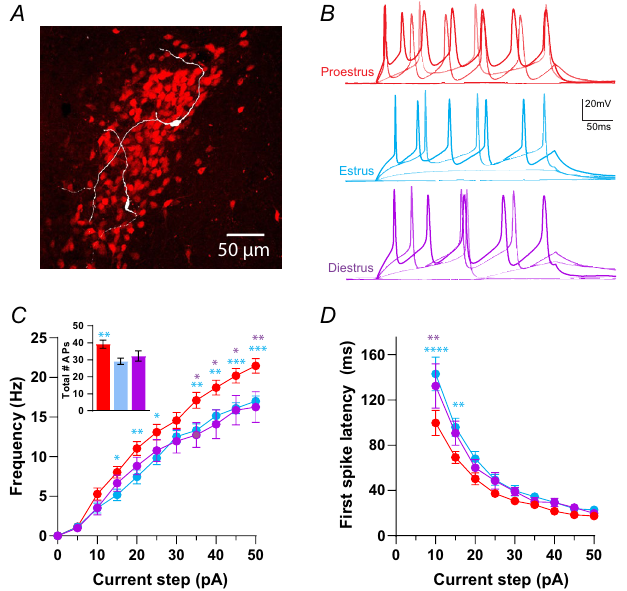
Figure 1. CRH neuron intrinsic excitability varies across the female estrous cycle. ( A ) Image of left hemisphere PVN showing expression of tdTomato (red) in CRH neurons. White cells are tdTomato positive CRH neurons that have been filled with neurobiotin via the whole cell recording pipette. ( B ) Representative responses of CRH neurons to 0 pA, 10 pA, 30 pA and 50 pA current steps. Proestrus in red, estrus in blue and diestrus in purple. ( C ) Summary data for the F/I curve. Cells from proestrus animals (n = 29 cells) show a significantly higher firing frequency compared to those from estrus (n = 38) and diestrus (n = 22). Symbols denote significance determined by Tukey’s post hoc multiple comparisons test (Two-way ANOVA results in Supplementary Table 1), blue: proestrus versus estrus, purple: proestrus versus diestrus. Insert shows total number of APs fired over all current steps for each group. ( D ) Graph of first spike latency (FSL) for each current step. Cells from proestrus animals had a shorter FSL at 10 and 15 pA steps. Stars are results of post hoc multiple comparisons, as in B. N = 9, 15 and 10 mice for diestrus, estrus, and proestrus groups respectively. P values: * ≤ 0.05, ** ≤ 0.01, *** ≤ 0.001, **** ≤